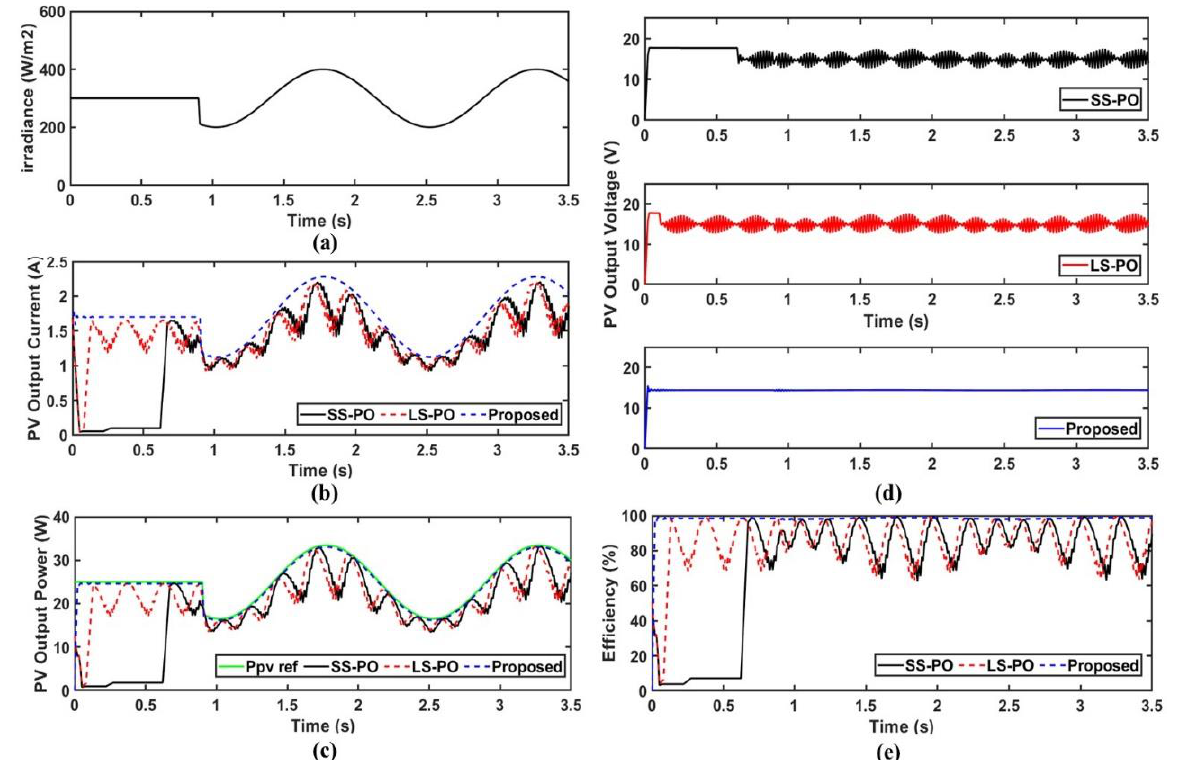
Figure 12. PV results: ( a ) sinusoidal irradiance profile. ( b ) PV output current. ( c ) PV output power. ( d ) PV output voltage. ( e ) System-tracking efficiency.